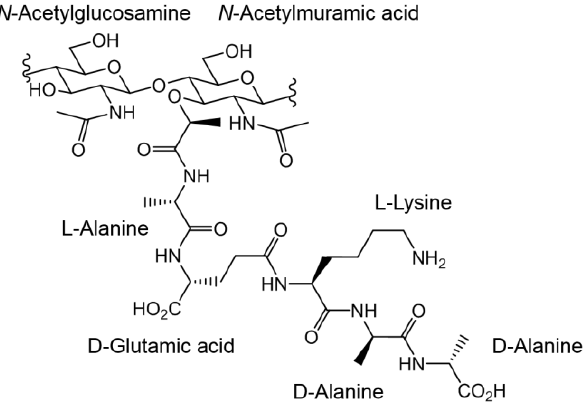
Figure 7. Chemical structure of the peptidoglycan precursor in Gram-positive cells.